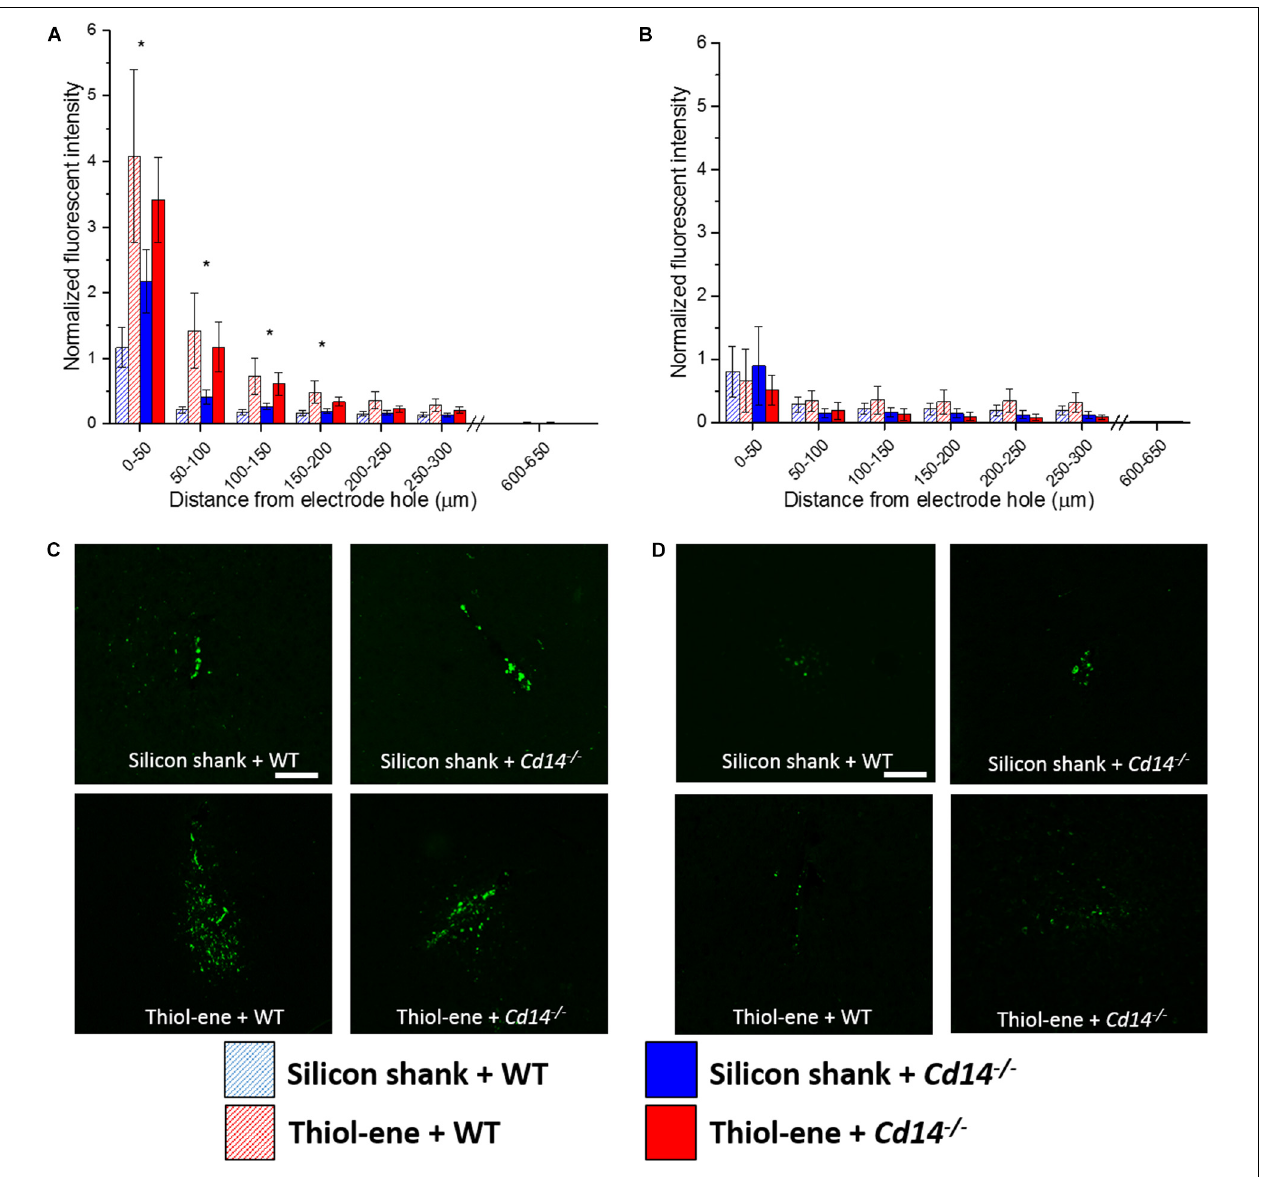
FIGURE 4 | Immunohistochemical evaluation of activated microglia and macrophages. Microglial and macrophage activation evaluated as CD68 expression with respect to distance from the explanted probe hole ( µ m). (A) 2 weeks. (B) 16 weeks. (C) Representative images of 2 weeks activated microglia and macrophages. (D) Representative images of 16 weeks activated microglia and macrophages. Scale bar: 100 µ m. ∗ Denotes significance between silicon and thiol-ene